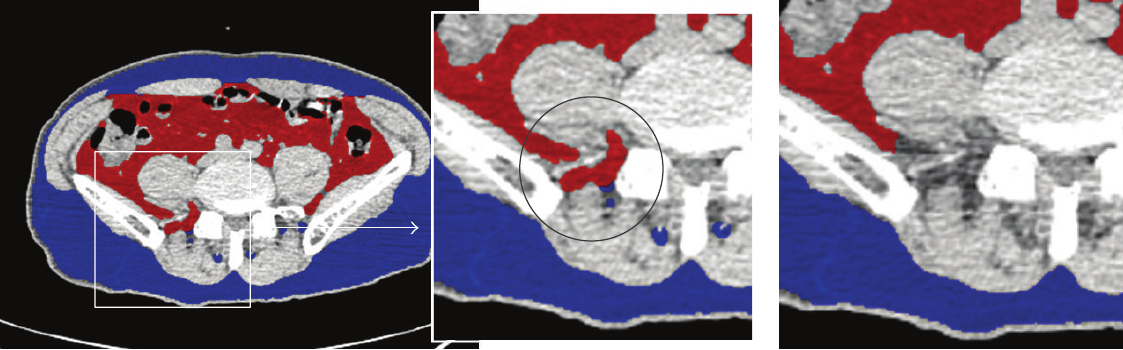
Figure 5: Examples of overestimation of visceral fat area by the proposed